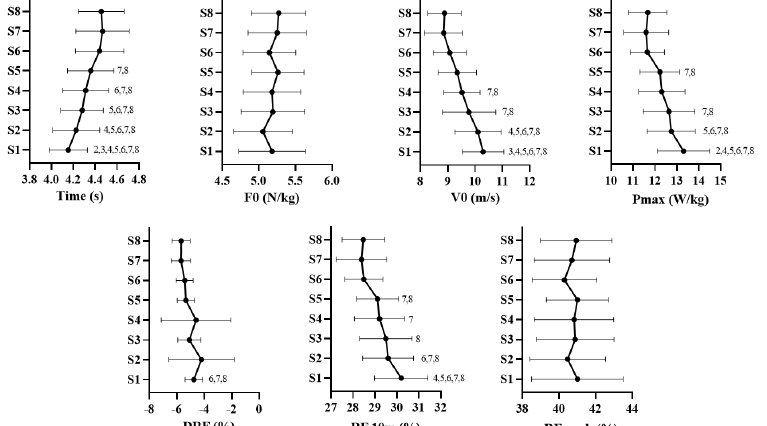
Figure 1. Differences between sprints for the variables of the horizontal force-velocity profile. F0: theoretical maximum force; V0: theoretical maximum speed; Pmax: maximum power; DRF: rate of decrease in force index produced at each step; RF 10 m: force index in the first 10 m; RFpeak: maximum value in force index. 2 = statistically significant difference with sprint number 2; 3 = statistically significant difference with sprint number 3; 4 = statistically significant difference with sprint number 4; 5 = statistically significant difference with sprint number 5; 6 = statistically significant difference with sprint number 6; 7 = statistically significant difference with sprint number 7; 8 = statistically significant difference with sprint number 8.